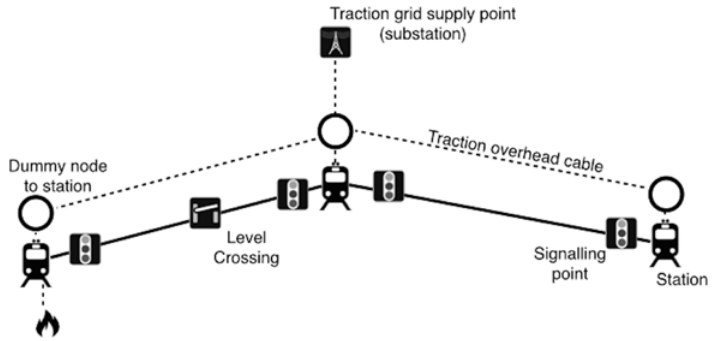
Figure 6. Illustration of functional (topological and operational) connectivity of certain assets to the railway network. Assets such as level crossings, signalling points or point heating are connected to their nearest node (station/junction) or edge. Assets such as traction electricity substations are connected to their nearest node and through overlaying a series of overhead cables along the network the electricity is supplied to other